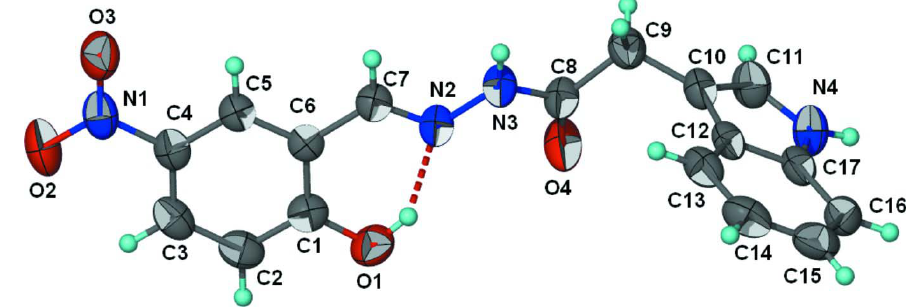
Figure 1 Thermal ellipsoid plot of (I) (Barbour, 2001) at the 50% probability level. Dashed line indicates H-bonding. N ′ -(2-Hydroxy-5-nitrobenzylidene)-2-(1 H